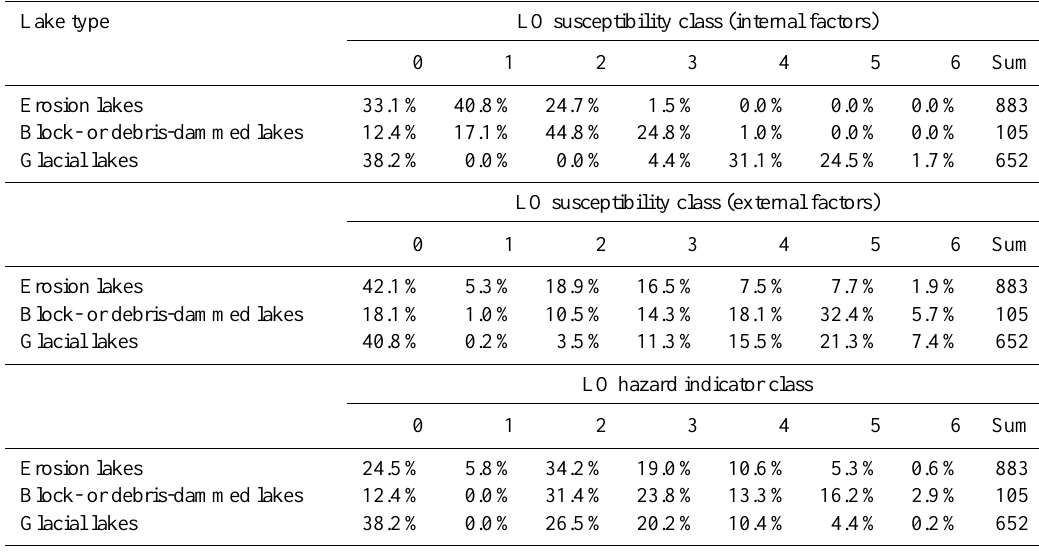
Table 10. Percentage of lakes assigned to each lake outburst (LO) susceptibility (internal and external factors) and hazard indicator class according to lake type.